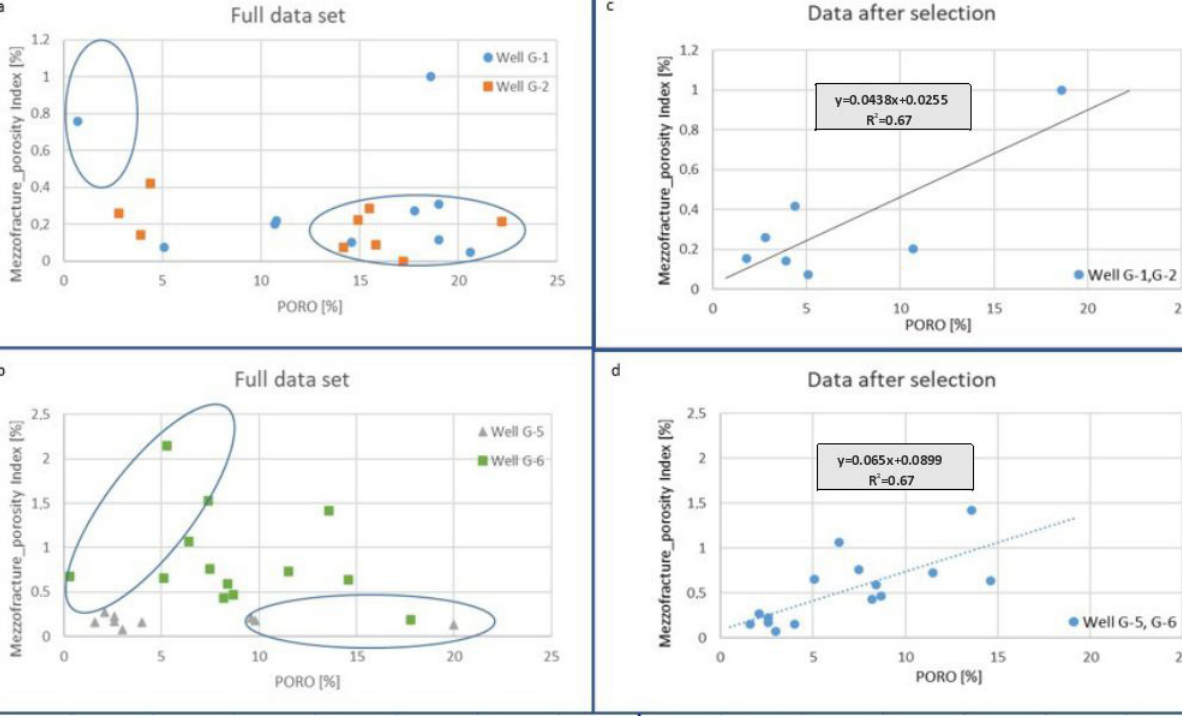
Figure 8. Mezzofracture_porosity Index vs. PORO: ( a ) full data set, G-1 and G-2 boreholes; ( b ) full data set, G-5 and G-6 boreholes; ( c ) data after selection, G-1 and G-2; ( d ) data after selection, G-5 and